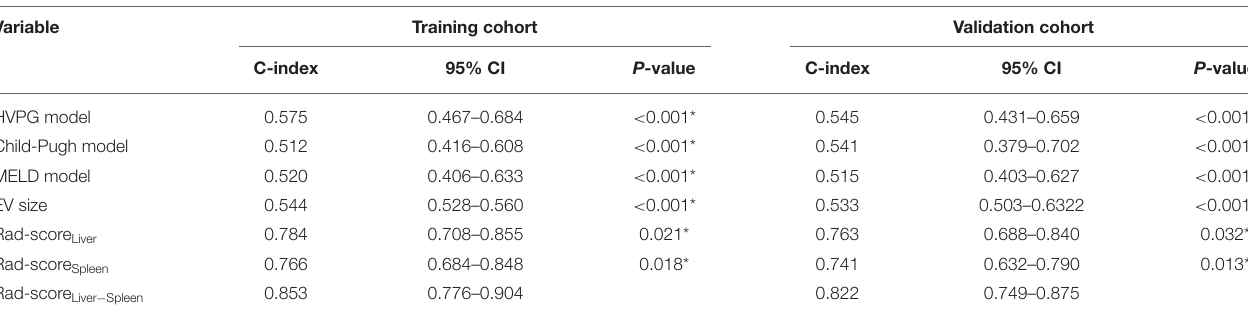
TABLE 3 | C-indexes of different